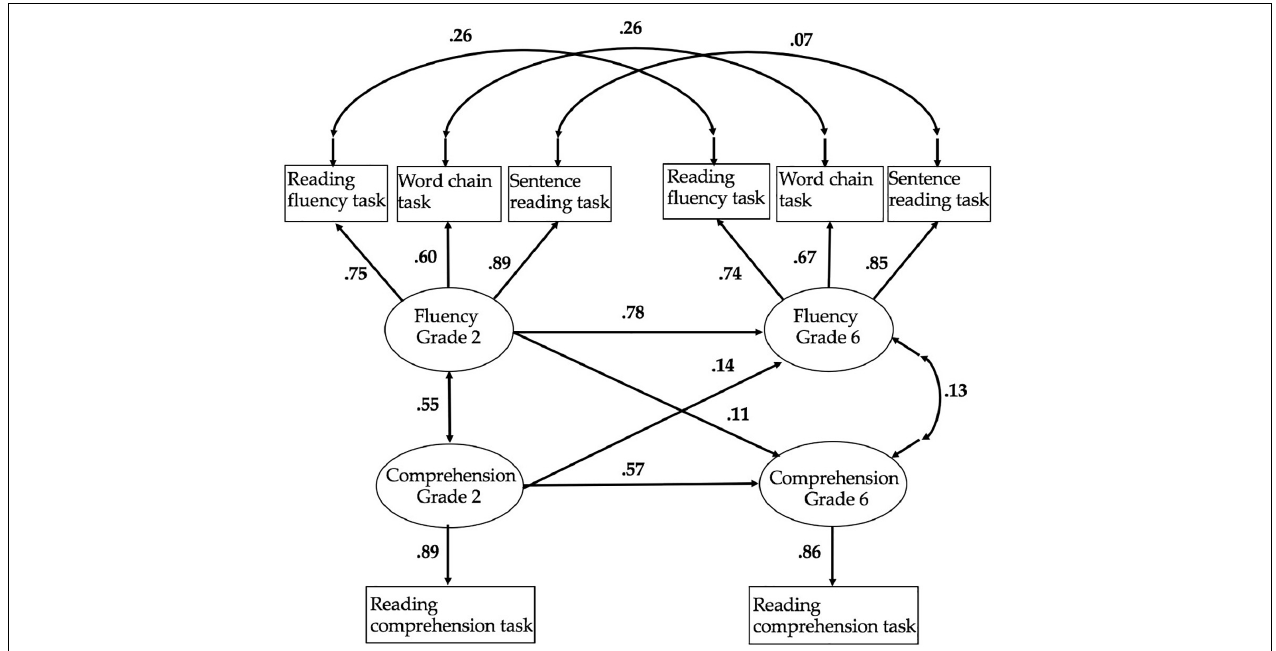
FIGURE 1 | Standardized path estimates of the cross-lagged model. The figure presents standardized estimates using listwise analysis.